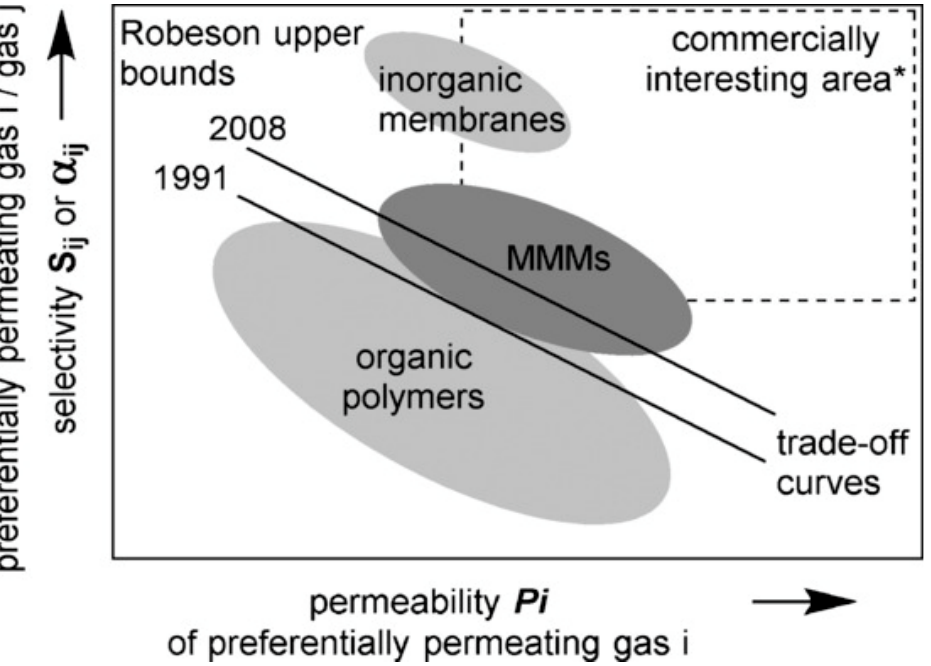
Figure 4. Robeson trade-off analysis selectivity and permeability in MMMs, inorganic, and polymeric membranes Reprinted/adapted with permission from Dechnik et al. [66] (2017) John Wiley and Sons.